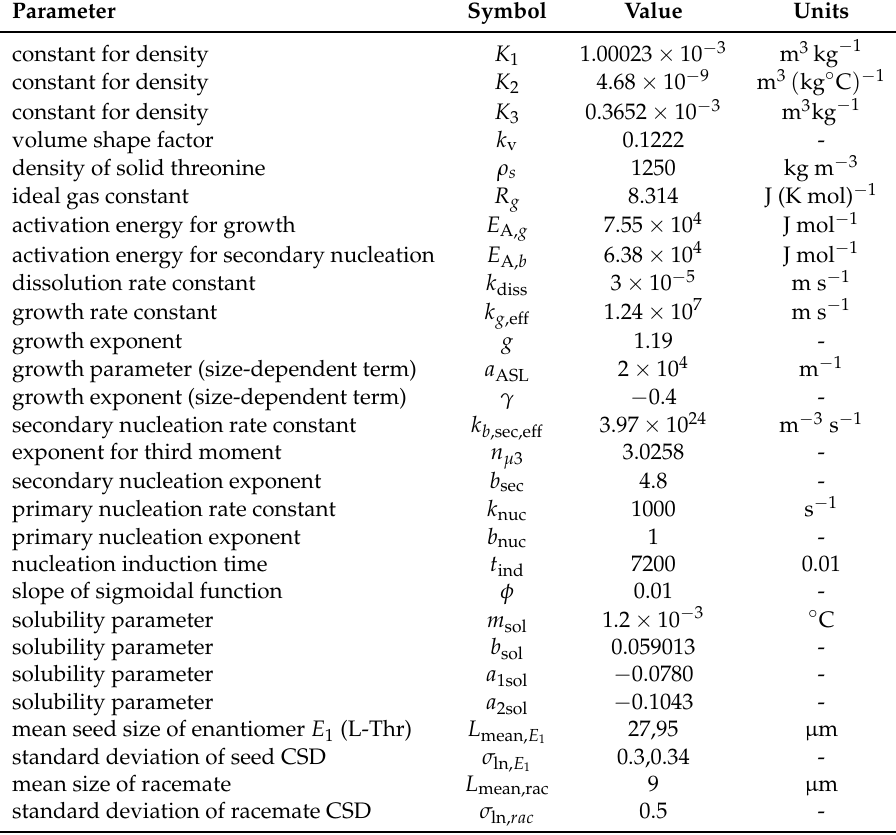
Table A1. Kinetic and simulation parameters for the Ternary System D-/L-threonine/H 2 O [14,46]. (Reprinted (adapted) with permission from Eicke, M.J.; Levilain, G.; Seidel-Morgenstern, A. Efficient resolution of enantiomers by coupling preferential crystallization and dissolution. Part 2: A parametric simulation study to identify suitable process conditions; American Chemical Society, 2013; and with permission from Qamar, S.; Elsner, M. P.; Hussain, I.; Seidel-Morgenstern, A. Seeding strategies and residence time characteristics of continuous preferential crystallization; Elsevier, 2012.)